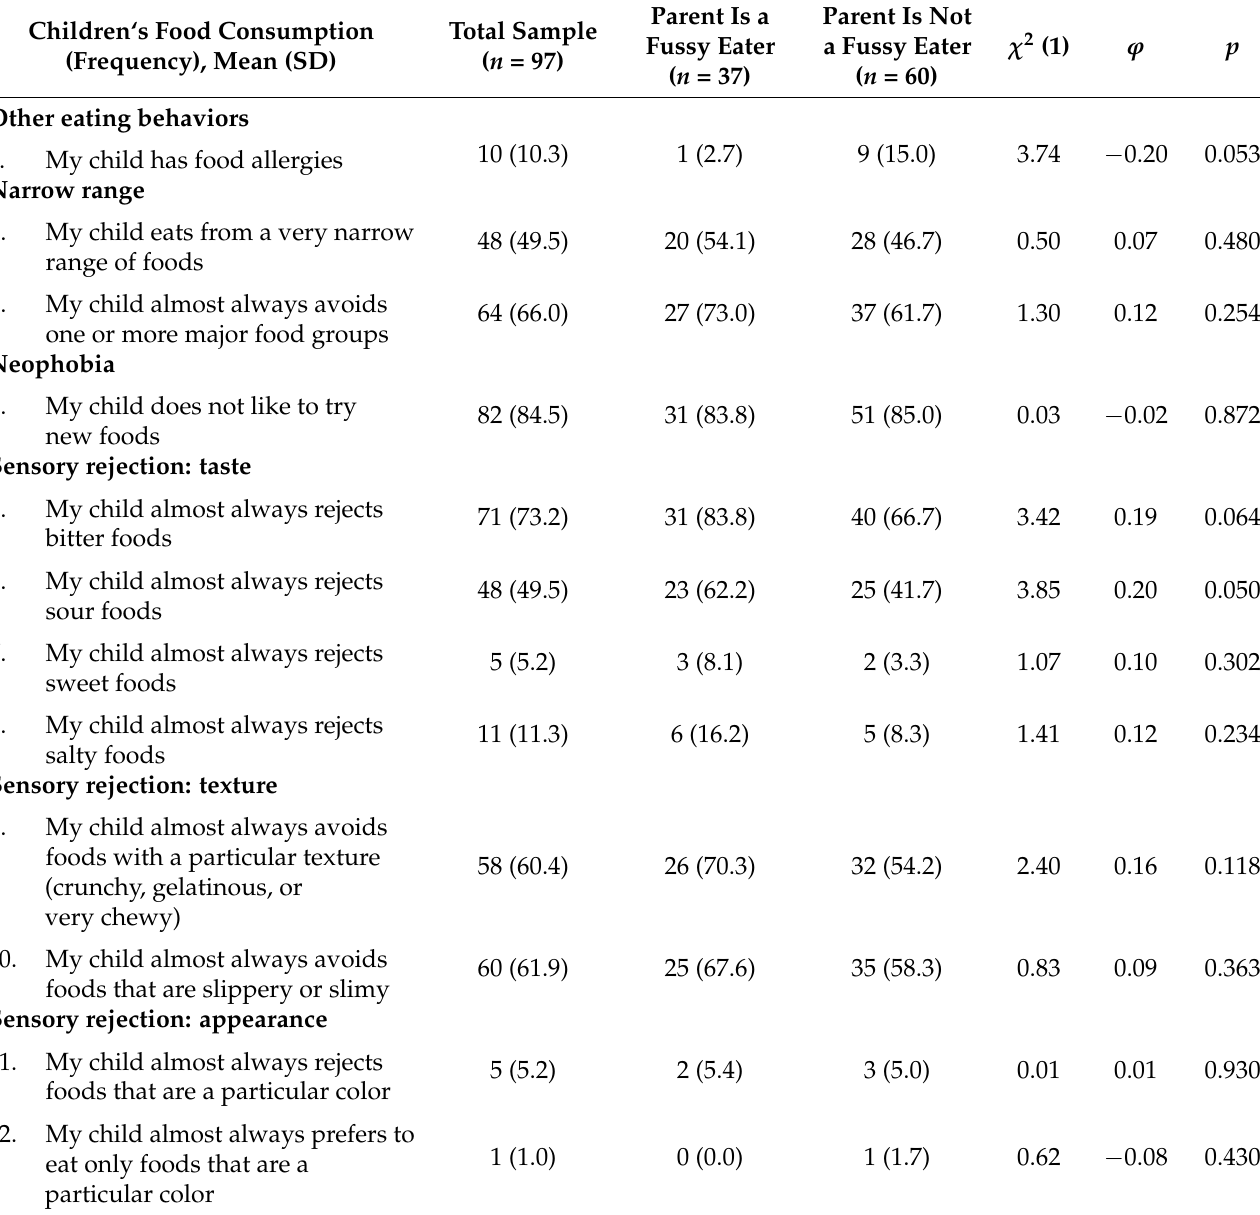
Table 5. Children’s food related behaviors based on parents’ fussy eating. Results are presented as n (%).